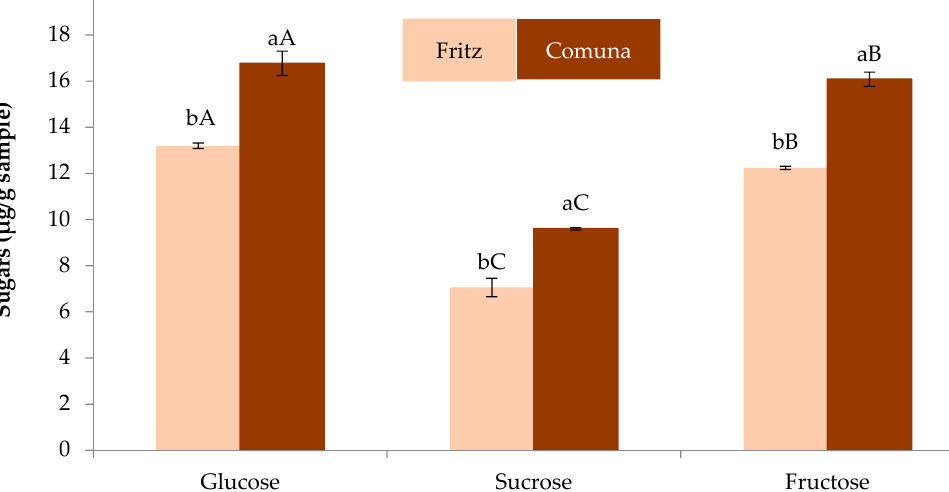
Figure 2. Sugar content of almond skin flours obtained from Turrón coproducts. For the same compound, bars followed by different lowercase letter are significantly different ( p < 0.05) according to Tukey’s Multiple Range Test. For the same almond skin bars followed by different capital letter are significantly different ( p < 0.05) according to Tukey’s Multiple Range Test.